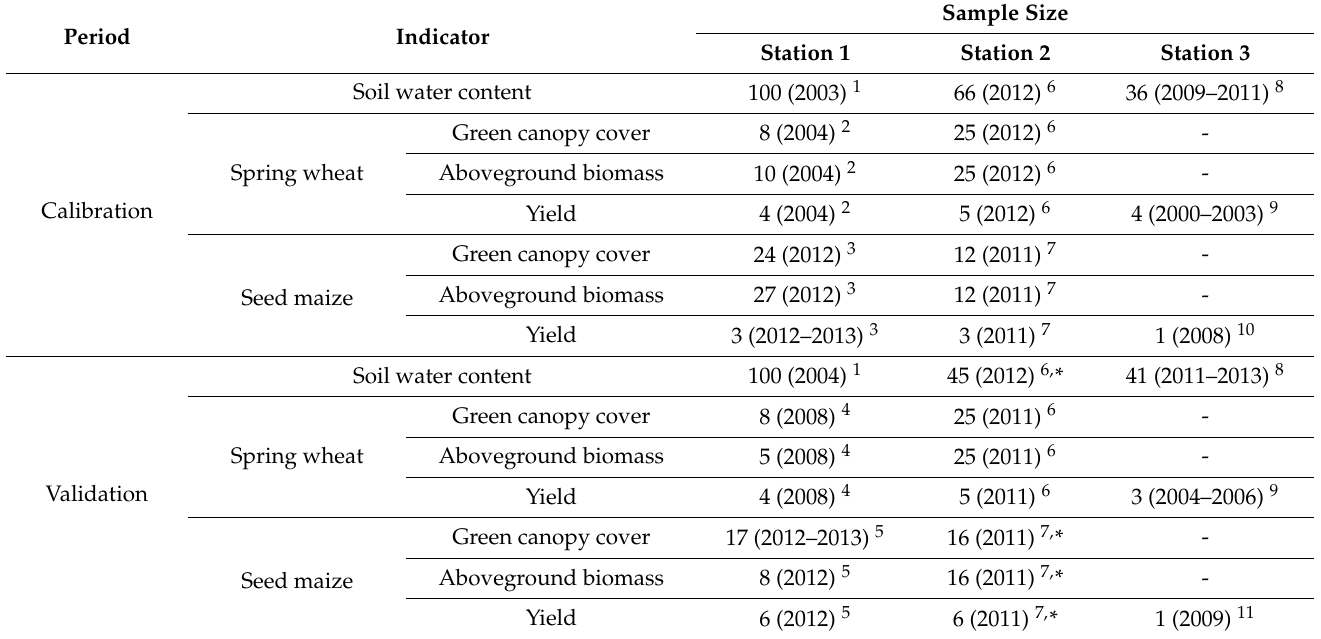
Table 2. Data collected from the literature for crop parameter calibration and